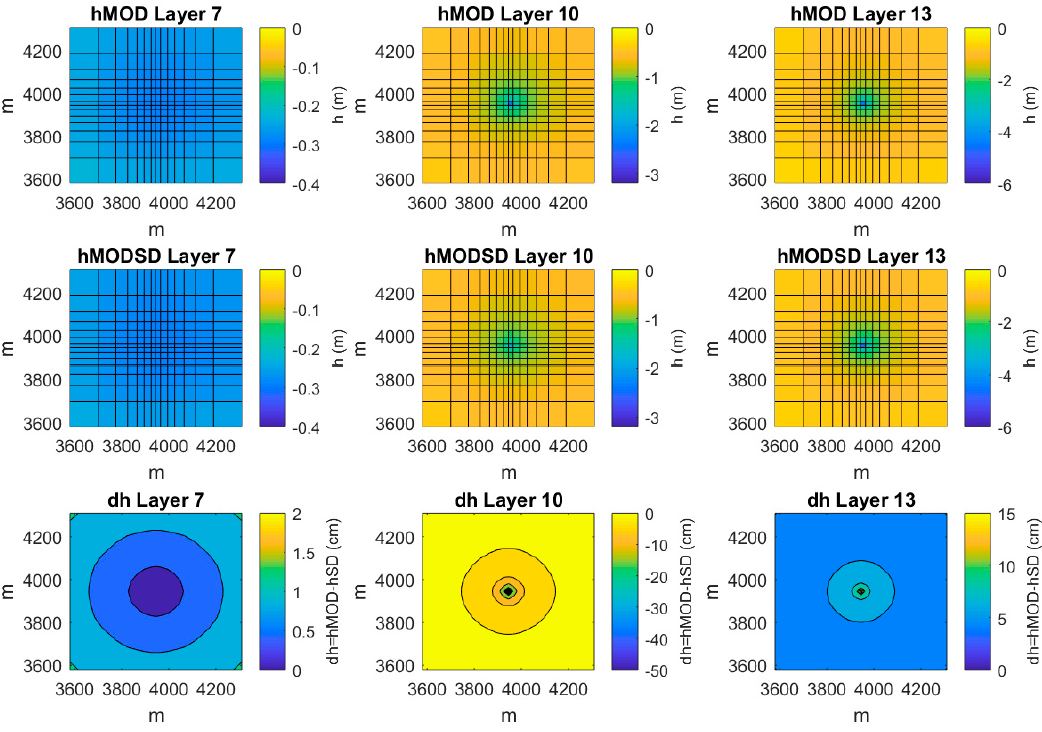
Figure 6. Results of groundwater heads calculated by MODFLOW and MODFLOW-SD for layer 7 (the first confined aquifer, unit C), layer 10 (the middle layer in second confining unit, unit D), and layer 13 (the second confined aquifer, unit E). dh is the difference between heads estimated by the two models.